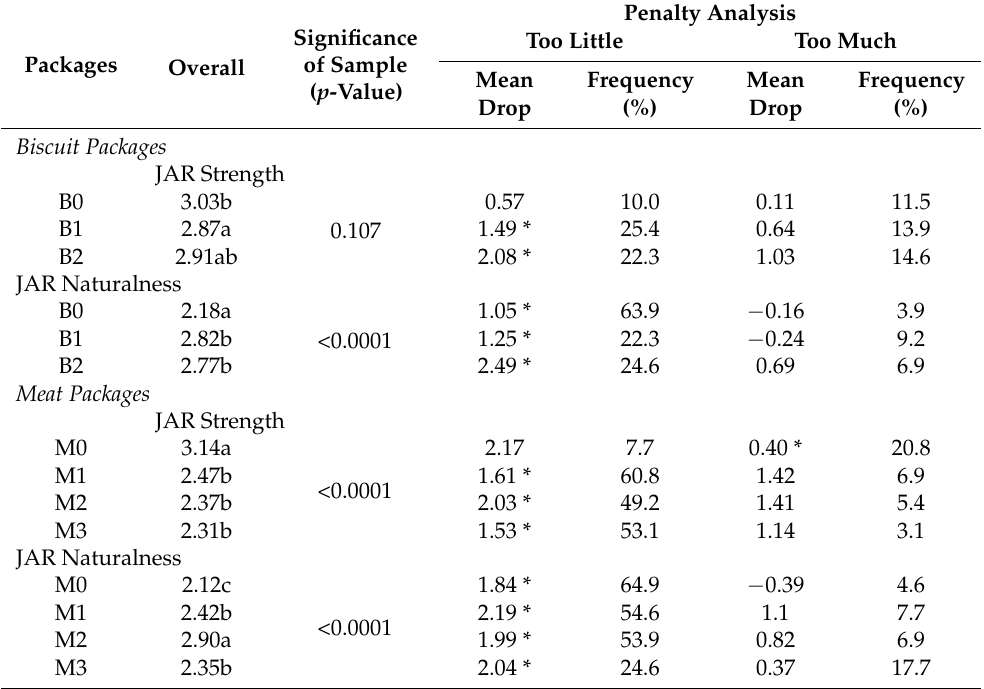
Table 7. Mean Just-About-Right ratings and influence on overall liking ratings.